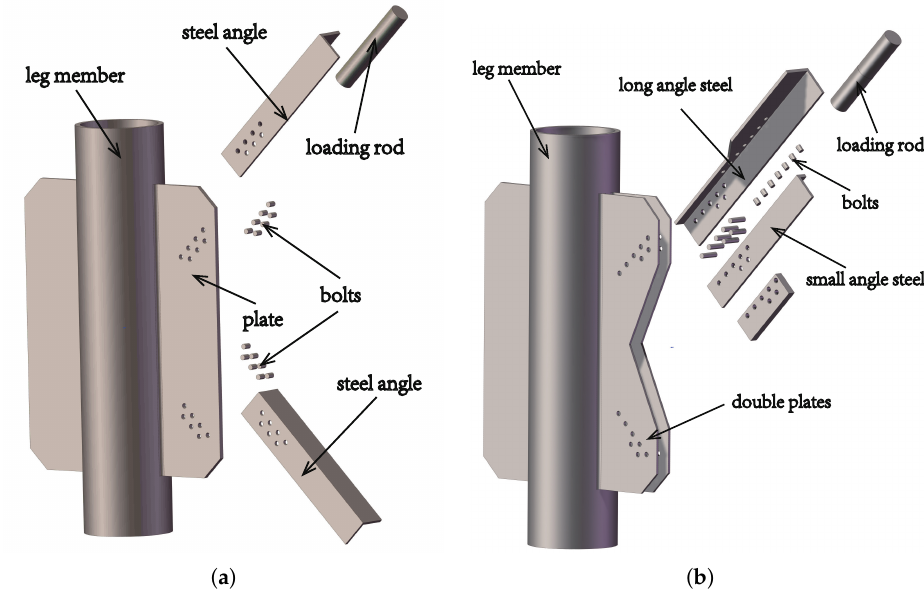
Figure 5. ( a ) The SLSPJ of triangular and quadrilateral lattice towers. ( b ) The DLDPJ of triangular and quadrilateral lattice